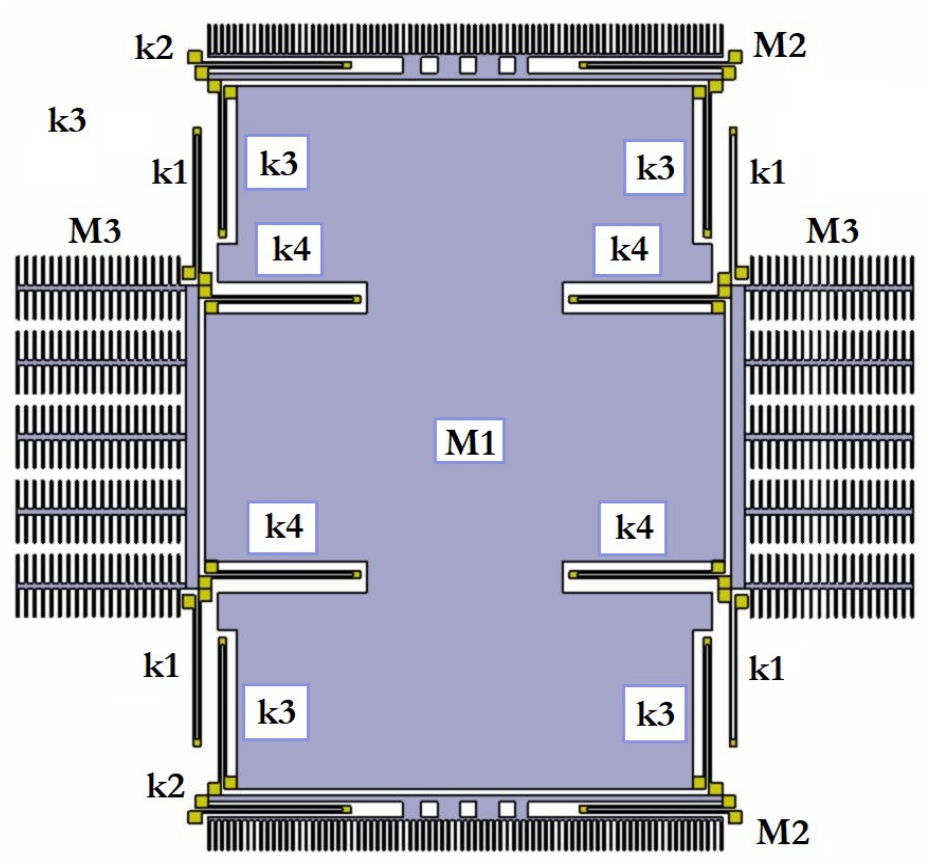
Figure 17. Schematic view of the elastic suspension of the SE of the MEMS